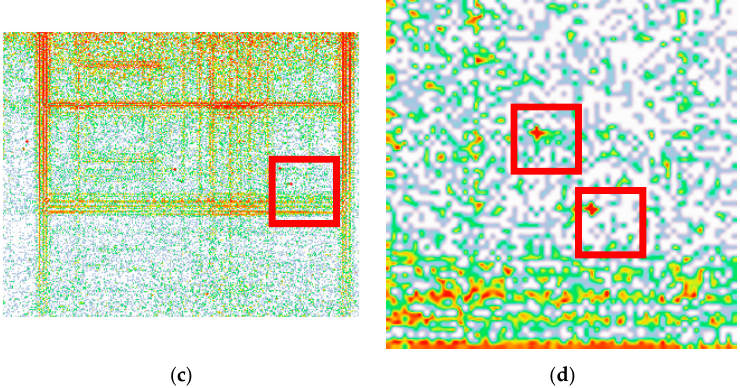
Figure 4. ( a ) Along track SWIR average L 1.1 ( x , y , λ ) ; ( b ) zoom of a middle right area of ( a ); ( c ) Anomaly map LAP _ HP ( x , λ ) and ( d ) zoom of ( c ) in the same region as in ( b )—both erroneous detectors at x = 249, λ = 1699.84 nm and x = 260, λ = 1783.87 nm where detected as ‘anormal’ and interpolated.